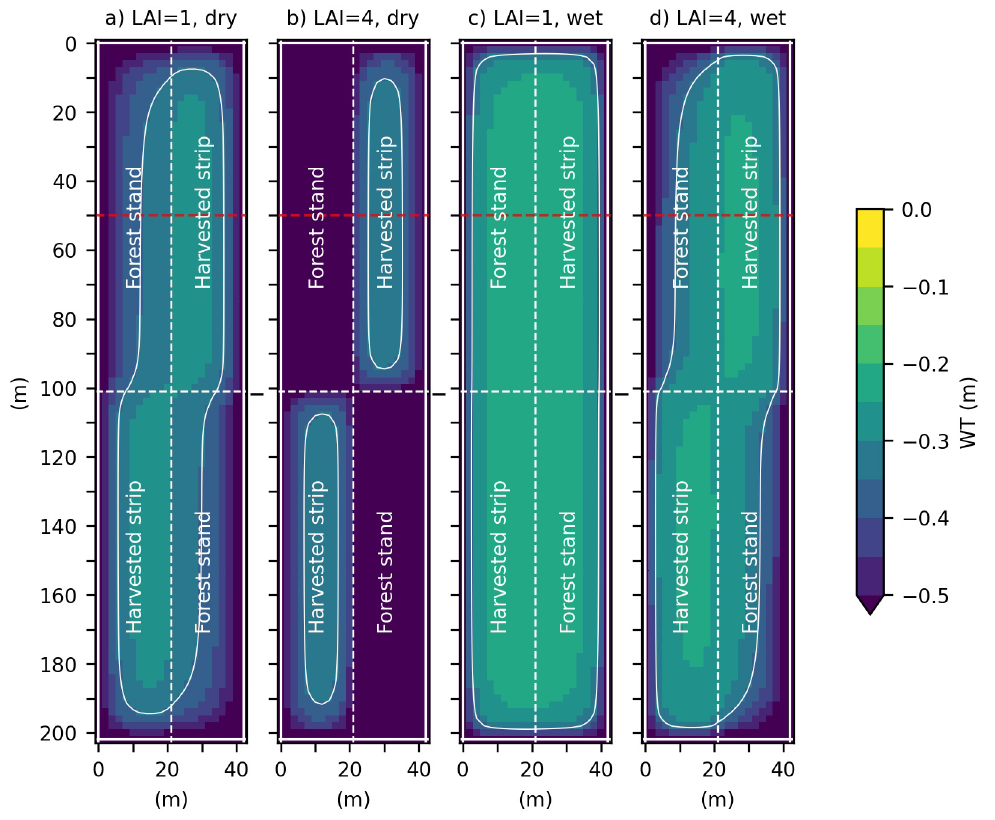
Figure 4. The simulated spatial mean and range of the daily WTs in 2017–2020 and the measured WTs within the unharvested forest stand ( a ) and the harvested (treeless) strips ( b ) at the Katila study site. Measurement data from tubes located at the edge of the forest and the harvested strips were omitted from this figure. The simulated WTs’ range covered the whole forest and harvested areas.